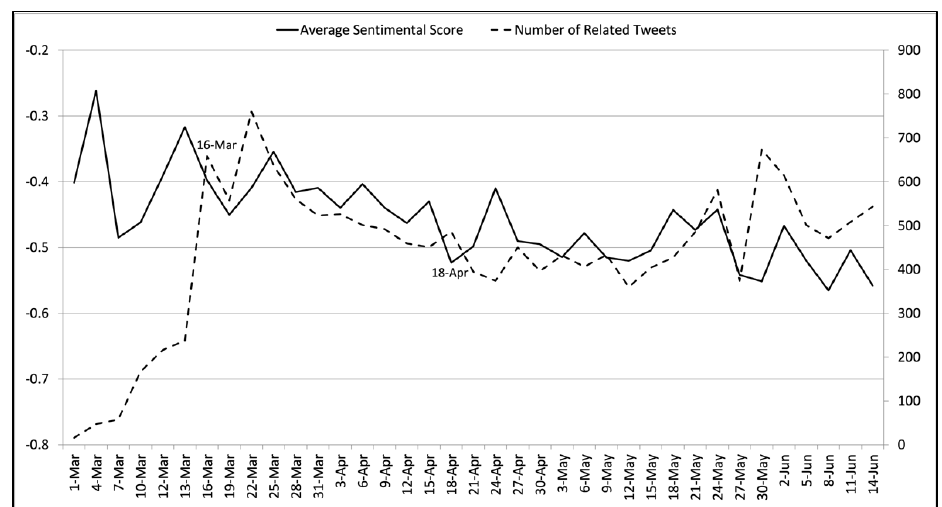
Figure 5. The average sentiment scores and the numbers of tweets related to the social distancing policy on each collection day from 1 March 2020 to 14 June 2020. The left vertical axis indicates average sentiment scores, while the right vertical axis suggests the number of related tweets collected. The horizontal axis shows the collection dates.